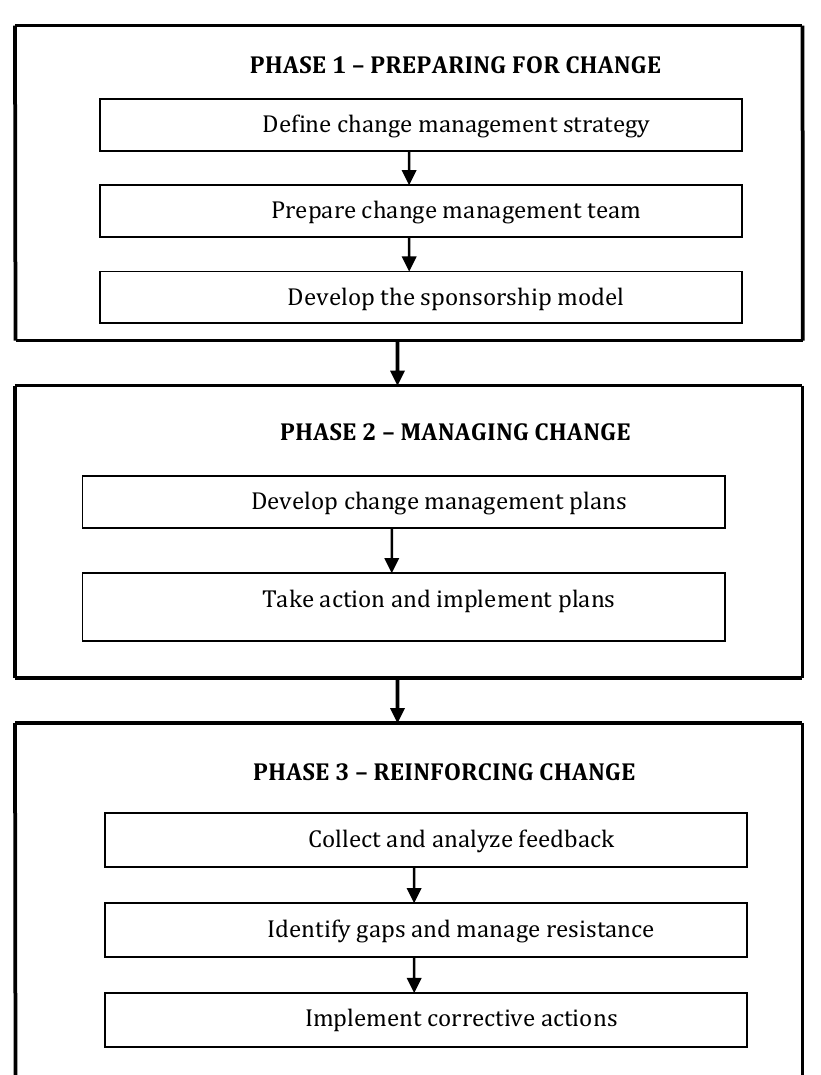
Figure 1: Change management process